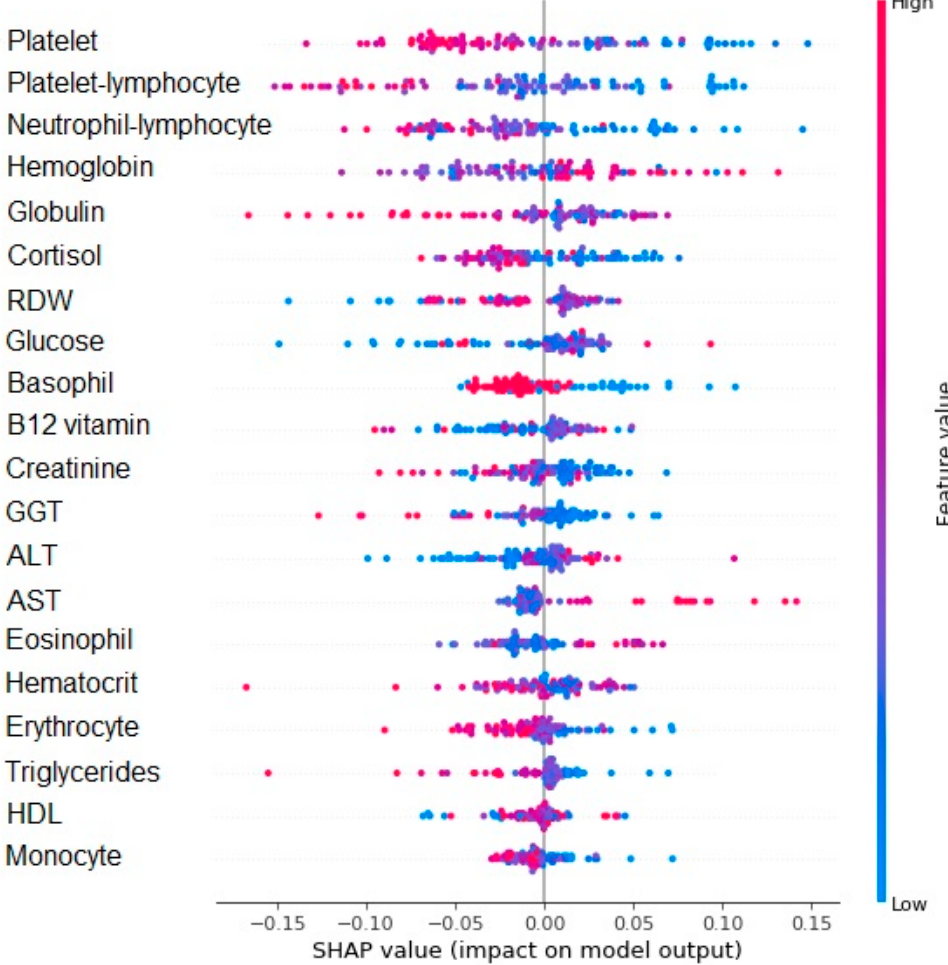
Figure 5. SHAP value for the random forest model regarding functional decline. Values below 0 on the X axis tend to not decline and values above 0 tend to cognitive decline. The red color indicates the greater value of the variable and the blue color indicates the lower value.